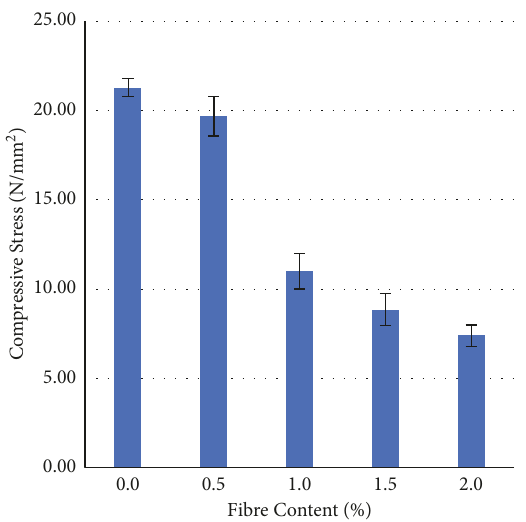
Figure 5: Effects of fibre addition on compressive stress of concrete.